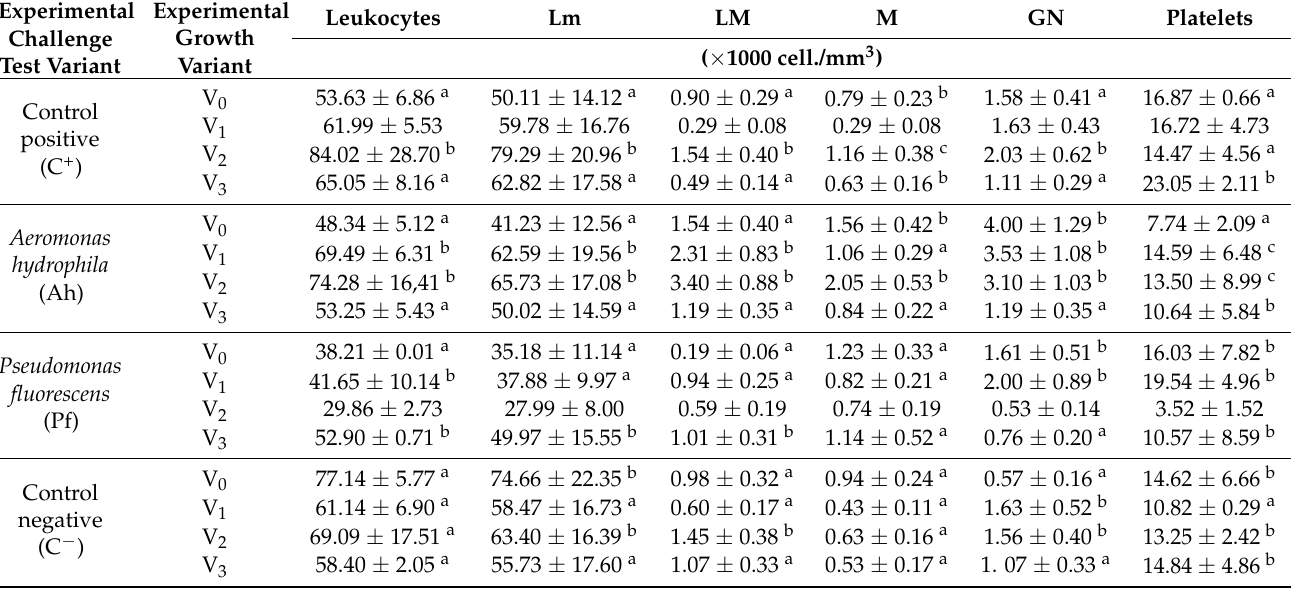
Table 5. Variations in the absolute number of leukocytes in Nile tilapia after challenge tests with Aeromonas hydrophila and Pseudomonas fluorescens